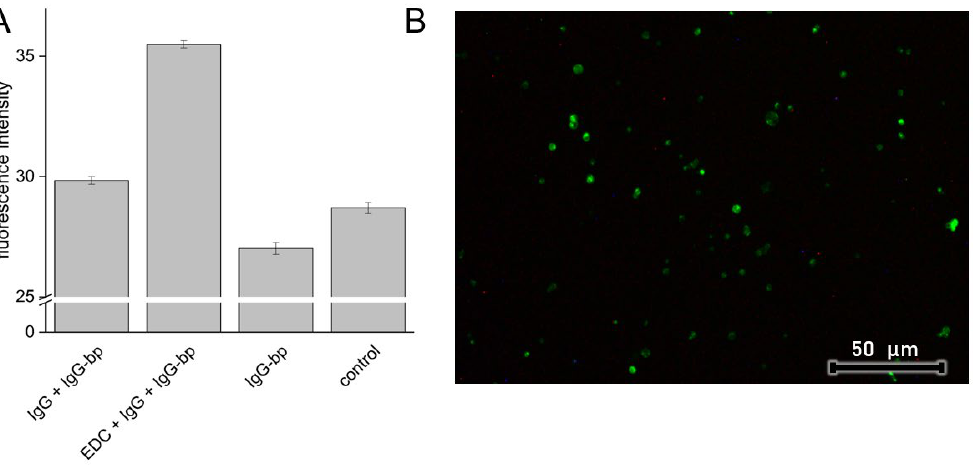
Figure 10. ( A ) Fluorescence intensity derived from crosslinked CHIT/HEP tetralayer coated PCL cores: subjected to EDC/NHS coupling reaction (EDC + IgG + IgG-bp), blank reaction (IgG + IgG-bp), incubated with IgG binding protein (IgG-bp) and non-treated particles (control); ( B ) Fluorescence microscopy micrograph of particles after EDC/NHS coupling reaction.